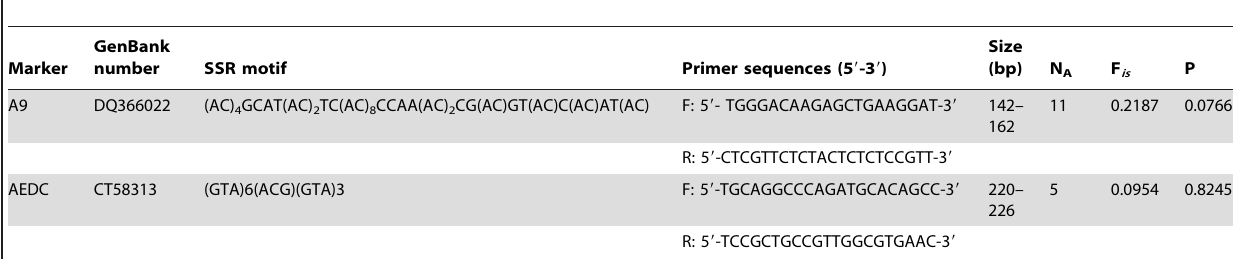
Table 1. Characteristics of microsatellites used for the assessment of the genetic structure of Aedes albopictus in La Re´union Island.